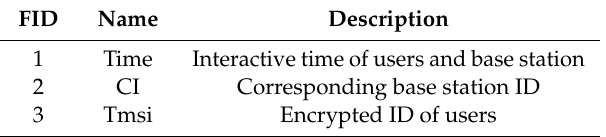
Table1. Calldetailrecord(CDR)datastructureinputforanalysis. FID—featureidentifier;ID—identifier.